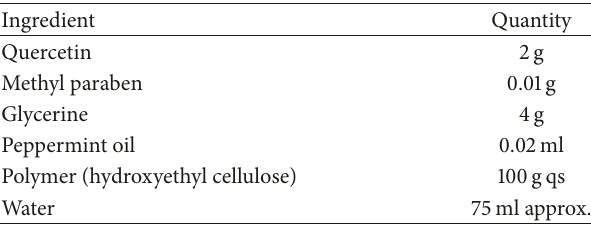
Table 1: Ingredient list.